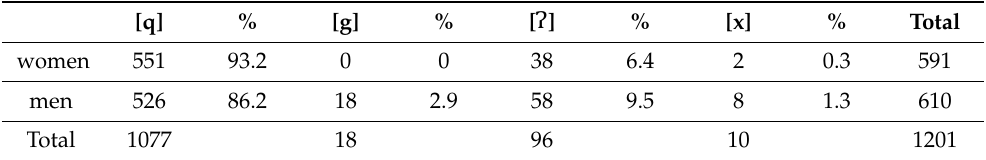
Table 6. Gender distribution of voiceless uvular and its